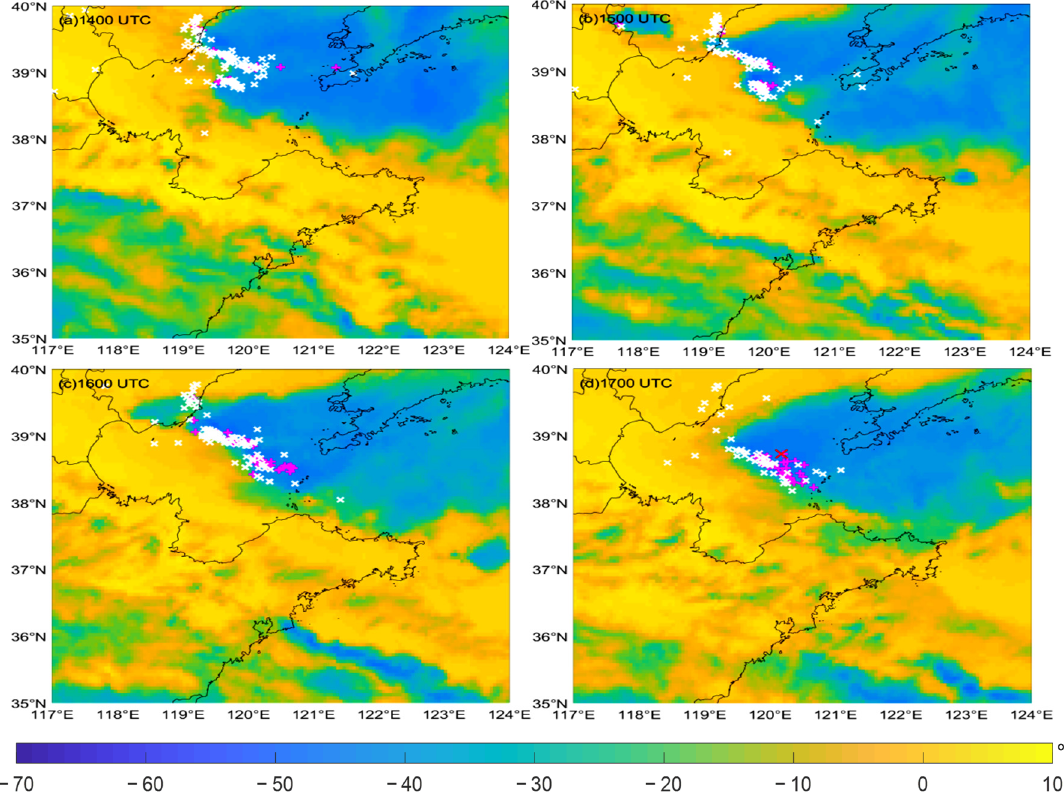
Figure 4. Cloud top brightness temperature from ( a ‒ d ) 14:00-17:00 on 31 May 2017, with flashes within 15 min centered at the time shown in the figure (the white “×,” rose red “+” and red “×” mark denote − CG fl ashes, +CG fl ashes, and sprite, respectively).